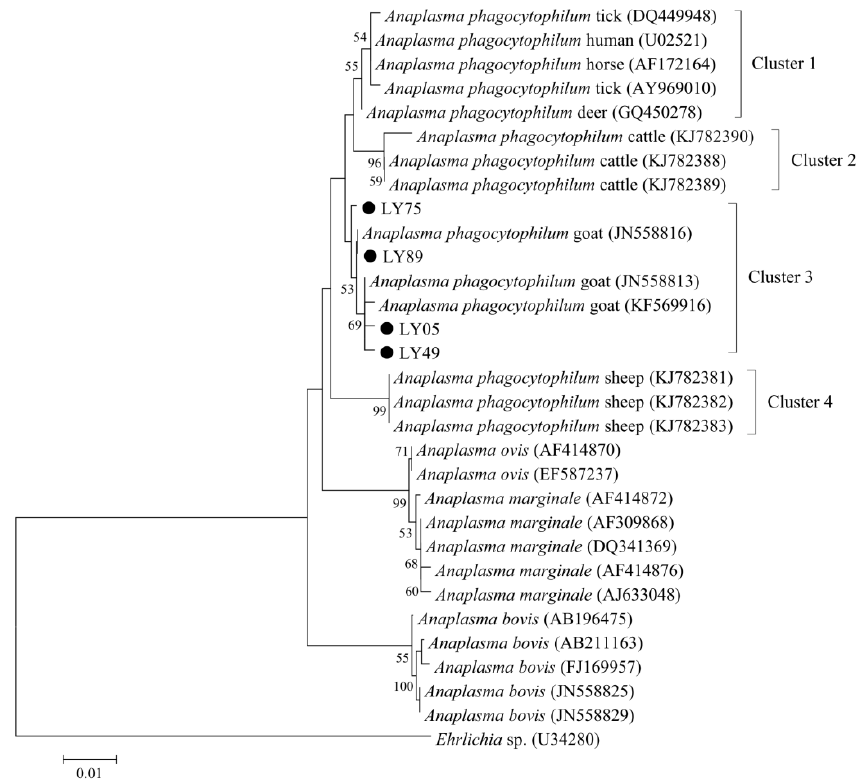
Figure 2. Phylogenetic relationships of Anaplasma phagocytophilum in the present study (black circle before the sample name) with reference sequences from GenBank TM based on the sequence analysis of the 16S rRNA gene by neighbor-joining analysis using the Kimura 2-parameter model. Bootstrap values (>50) are indicated at the nodes. Scale bar indicates 0.01 nucleotide substitutions/site. Ehrlichia sp. (U34280) is used as the outgroup.